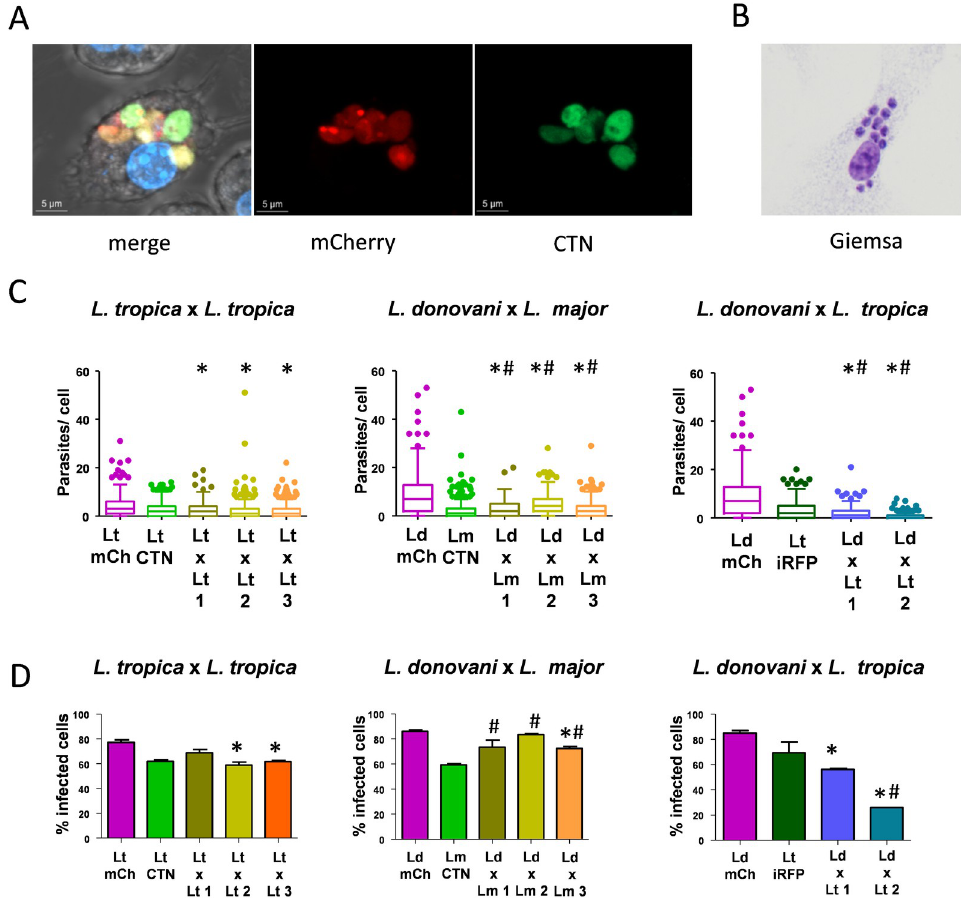
Fig 8. Infectivity of intraclonal and interspecies hybrids. (A) Representative image of confocal microscopy of a RAW cell infected with one hybrid of L . donovani mCh HYG x L . major CTN PAC. Merge and fluorescent pictures in the mCh (561 nm) and CTN (488 nm) channels are shown. (B) Representative image of BMMs infected with amastigotes of one hybrid of L. donovani mCh HYG x L . major CTN PAC and stained with Giemsa. (C) Box plots representing the number of amastigotes present within each BMM after in vitro infection withamastigotes of L . tropica mCh HYG (Lt mCh), L . tropica CTN PAC (Lt CTN), three intraclonal hybrids L . tropica mCh HYG x L . tropica CTN PAC (Lt x Lt 1, 2 and 3), L . donovani mCh HYG (Ld mCh), L . major CTN PAC (Lm CTN) three interspecies hybrids L . donovani mCh HYG x L . major CTN PAC (Ld x Lm 1, 2 and 3), L . tropica iRFP PAC (Lt iRFP), and two interspecies hybrids L . donovani mCh HYG x L . tropica iRFP PAC (Ld x Lt 1 and 2). (D) Bar graphs representing the percentage of infected BMMs after in vitro infection withamastigotes of L . tropica mCh HYG (Lt mCh), L . tropica CTN PAC (Lt CTN), three intraclonal hybrids L . tropica mCh HYG x L . tropica CTN PAC (Lt x Lt 1, 2 and 3), L . donovani mCh HYG (Ld mCh), L . major CTN PAC (Lm CTN) three interspecies hybrids L . donovani mCh HYG x L . major CTN PAC (Ld x Lm 1, 2 and 3), L . tropica iRFP PAC (Lt iRFP), and two interspecies hybrids L . donovani mCh HYG x L . tropica iRFP PAC (Ld x Lt 1 and 2). Differences were considered as significant when p < 0,05 and in a Kruskal-Wallist test (C) or in a one-way ANOVA analysis (D) (represented with an asterisk regarding the first parental line and with a hash regarding the second parental line).